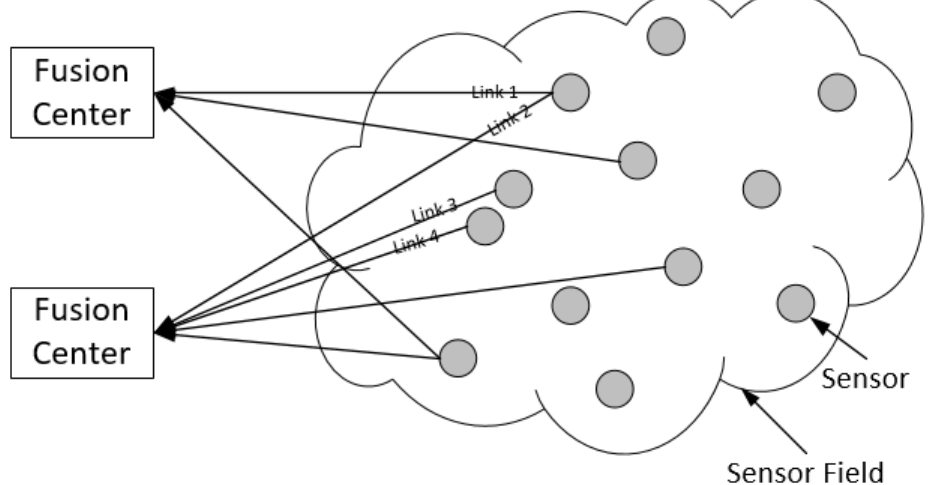
Figure 1. Wireless sensor network architecture for data fusion in